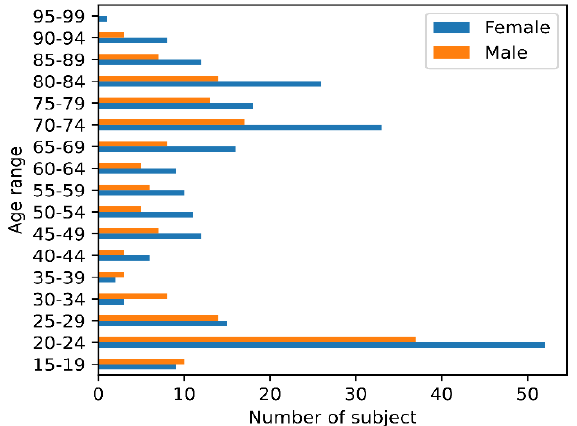
Figure 2. Age distribution for data set.